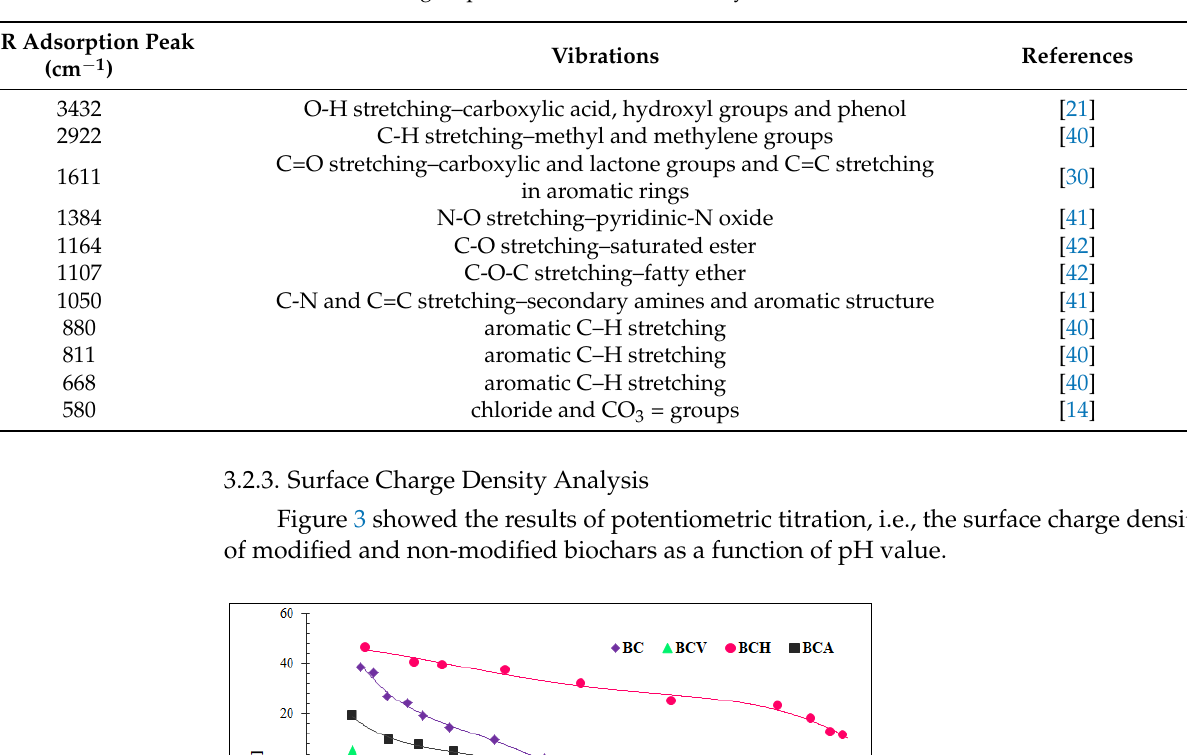
Table 4. Functional groups of biochar determined by FTIR.